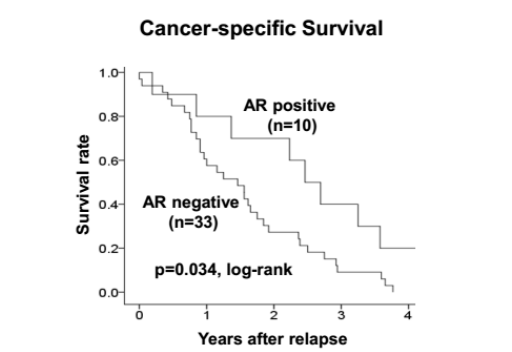
Figure 3. In relapse cases of TNBC. AR-positive TNBC had significantly good prognosis compared to negative cases. Table 3. Correlation between clinicopathological features and androgen receptor expression among 43 relapsed cases in 190 triple-negative breast cancer.